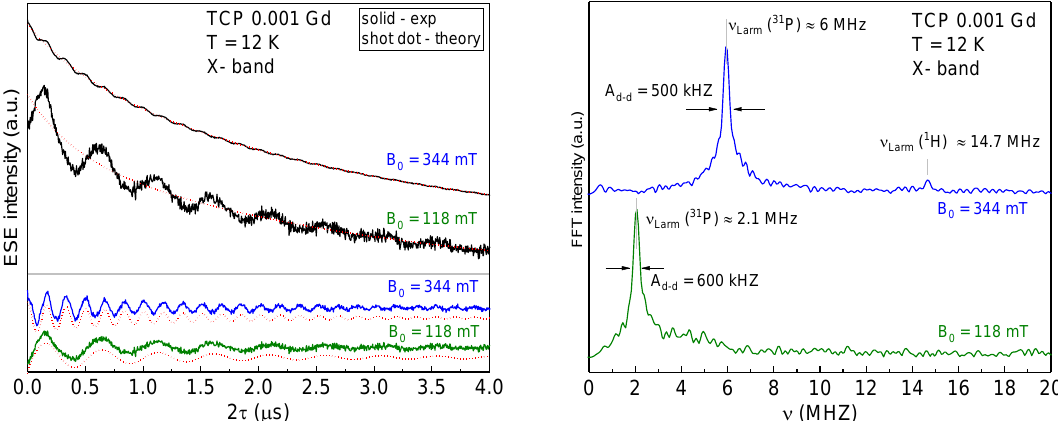
Figure 4. ( Left )—Curves of the decay of transverse magnetization (experimental and calculated) with the presence of nuclear modulation for two different values of magnetic fields before (top) and after (bottom) the subtraction of the monoexponential component. ( Right )—Spectra of nuclear transitions in the frequency range at different values of B 0 .